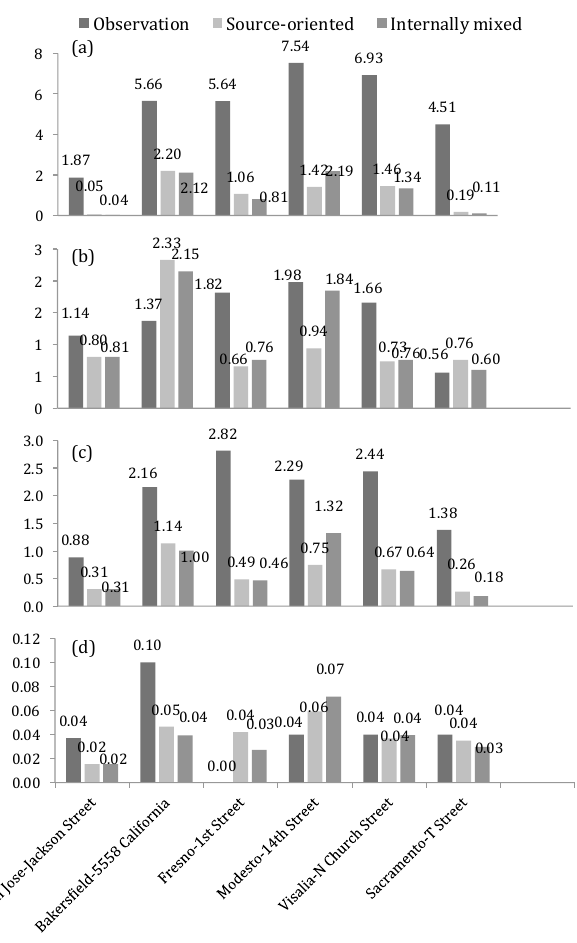
Figure 6. Comparison of (a) nitrate (NO − ), (b) sulfate (SO 2 − ), 3 4 (c) ammonium (NH + ) and (d) soluble sodium (Na + ) between sim- 4 ulated source-oriented experiment (S_ARon_CRmod), internally mixed experiment (I_ARon_CRmod) and the observed concentra- tions of airborne particles on 18 January 2011. Units are µgm − 3